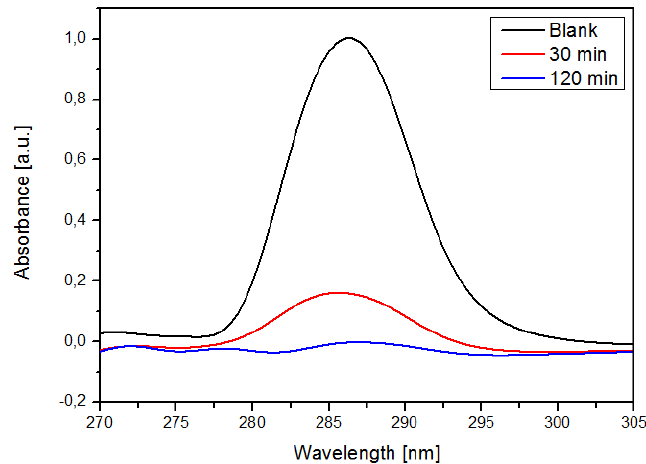
Figure 10. UV-VIS spectra of DTF after different contact times with NS.